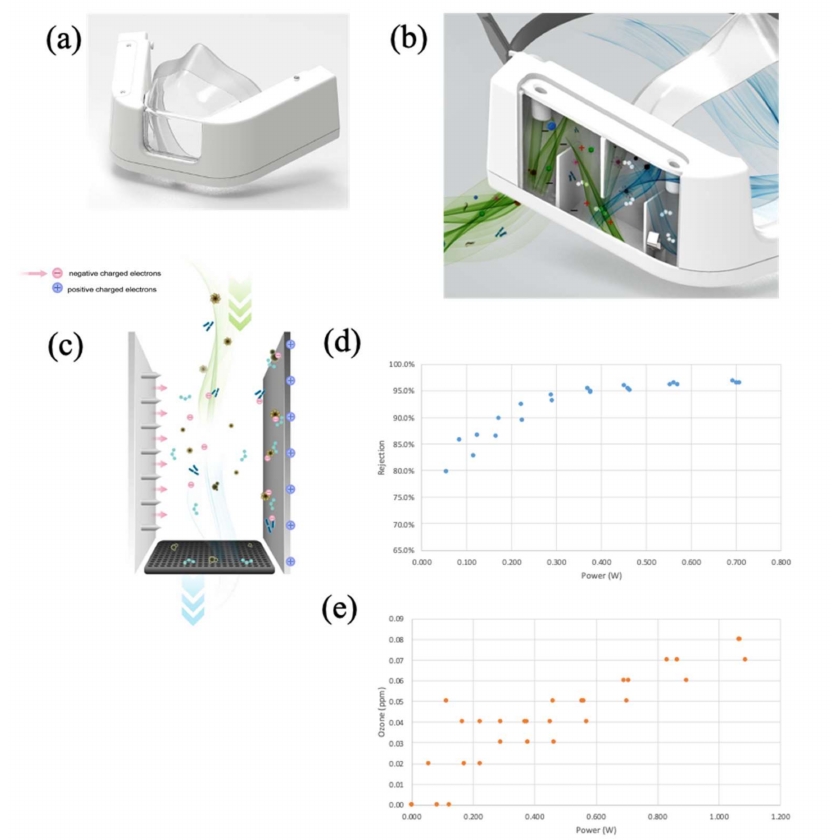
Figure 1. Protoyped mEP respirator. ( a ) Front view, picture. ( b ) Three-dimensional computer render- ing with side panel cover omitted to reveal internal mechanics of particle removal from inspiratory flow: green-colored air flow represents ambient air from inlet into mask; blue-colored air flow de- noted air with particles removed by the mEP respirator. ( c ) Three-dimensional computer rendering exploded view of the mEP unit within the mask, promotion of charged electrons and electrostatic precipitation, and collection plate. ( d ) Analytical determination of power and corresponding par- ticle removal percentage when operated at 85 lpm flow through the respirator inlet. ( e ) Analytical determination of power requirements to endogenous ozone generation by the